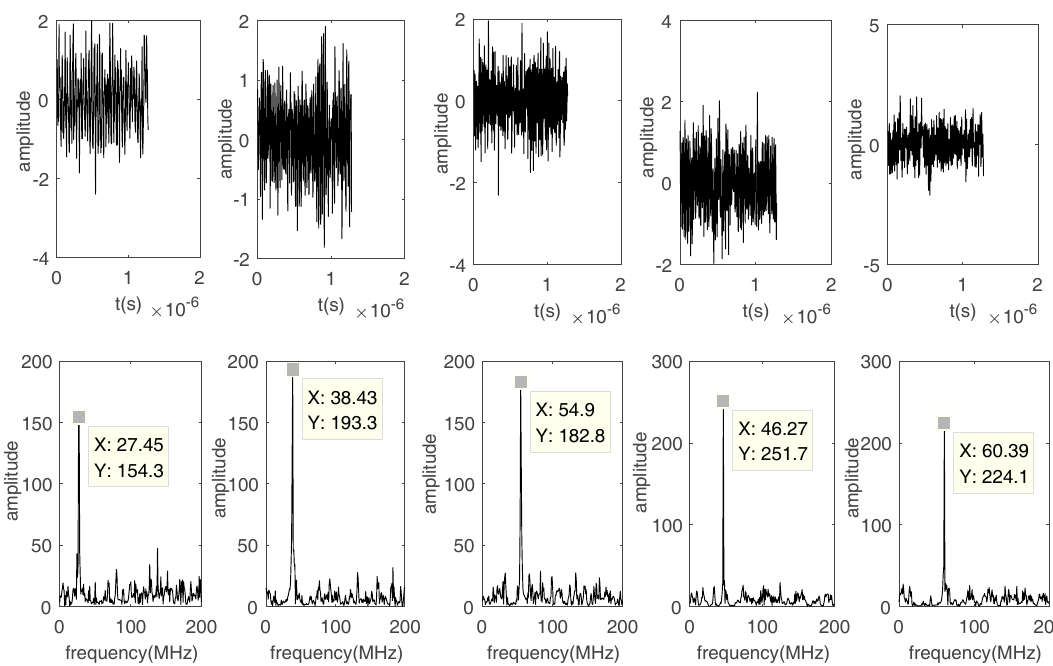
ε = 0.5. Figure 15. The waveforms and FFT results when SNR = 0 dB and ε 0 = 0.5. 0